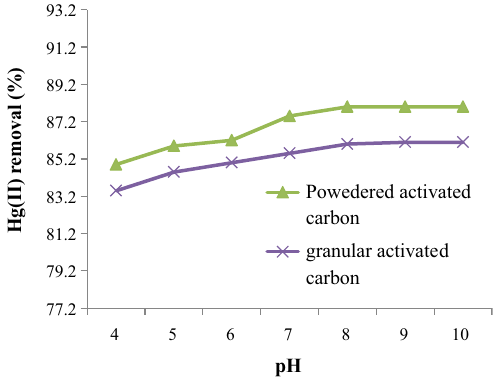
Fig. 8 Hg(II) removal (%) versus pH for powdered activated carbon (PAC) and granular activated carbon (GAC) at contact time 30 min, 20 g adsorbent, 40.41 mg/L Hg(II)